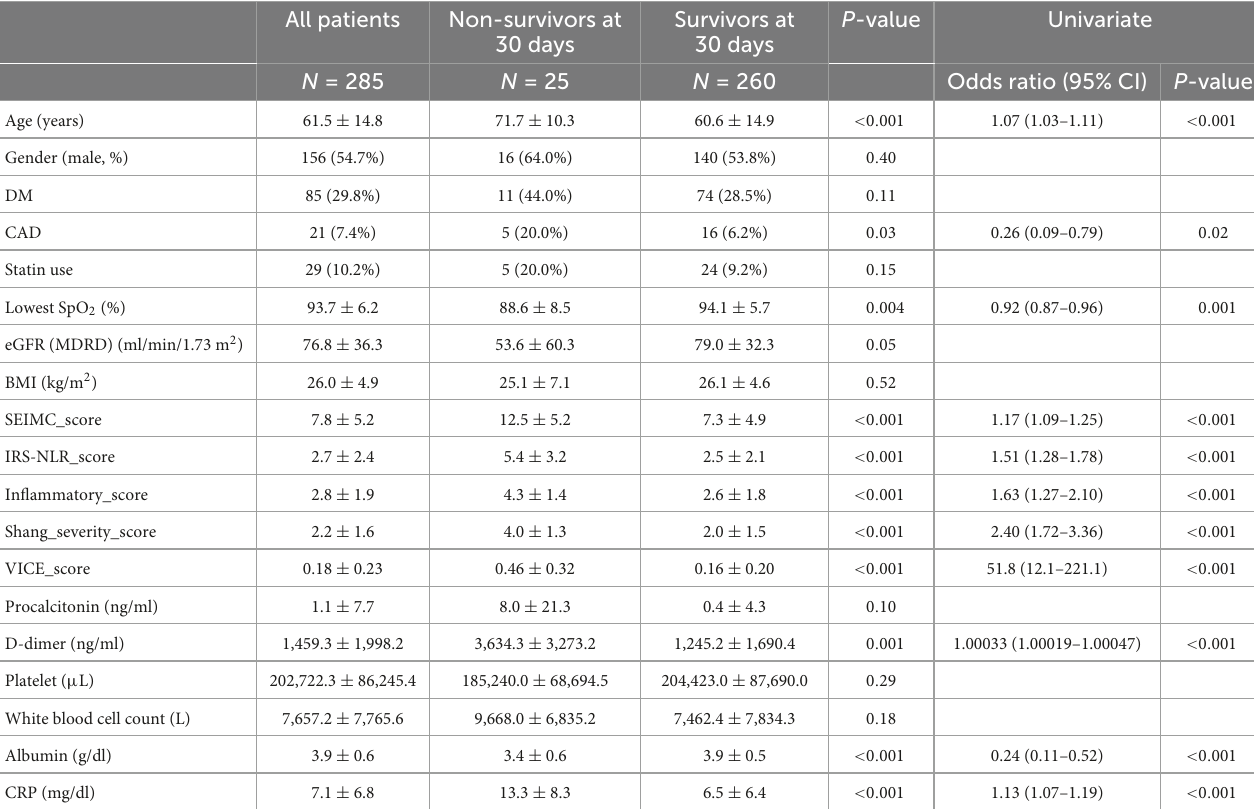
TABLE 1 Baseline characteristics and laboratory findings among survivors and non-survivors among hospitalized COVID-19 patients. All